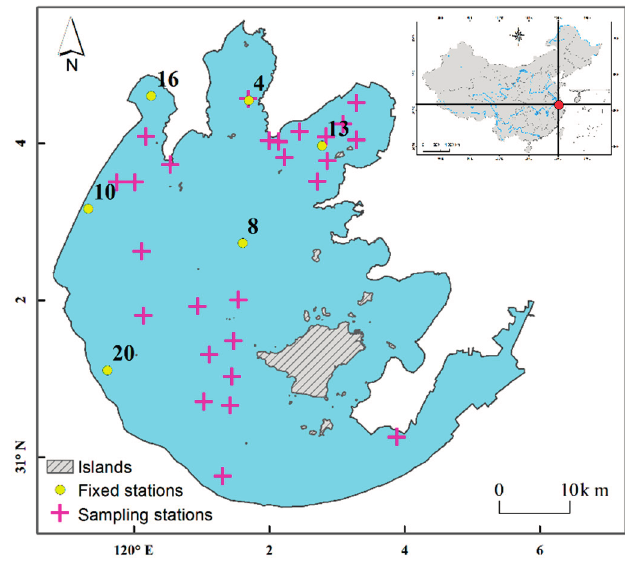
Figure 1. Taihu Lake in the Yangtze River Delta, China. Annotated on the image are locations of the 28 sampling stations visited by the six NIGLAS cruise surveys (October 2004, May 2008, October 2008, May 2010, March 2011 and May 2011) and 6 fixed sampling